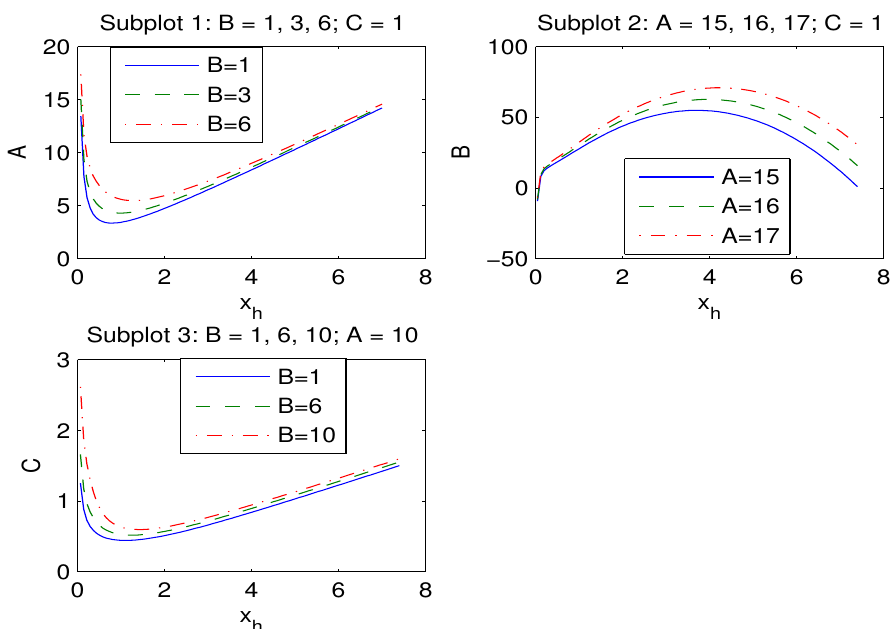
Figure 4. The plot of the functions A ( x h ) , B ( x h ) , C ( x h ) . ( A ) Subplot 1: B = 1, 3, 6; C = 1; ( B ) Subplot